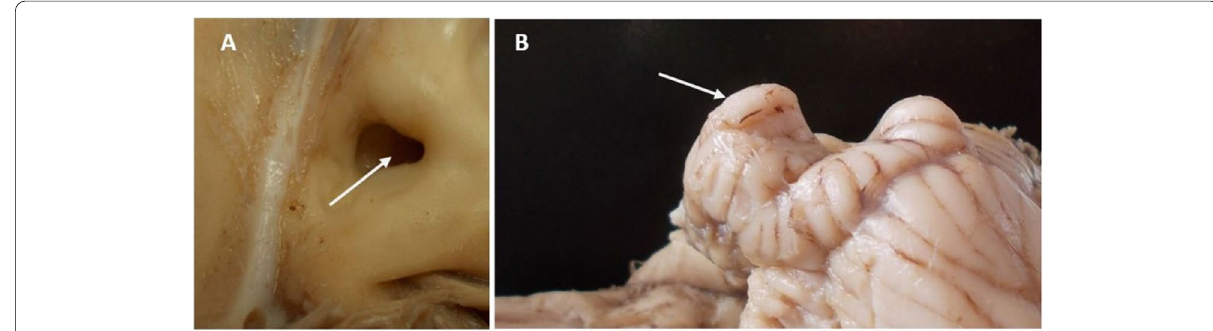
Fig. 11 Gross morphological images show the subarcuate fossa and involved part of the cerebellum. A. arrow shows the subarcuate fossa in the fresh sample. B. arrow shows the petrosal lobule of the cerebellar